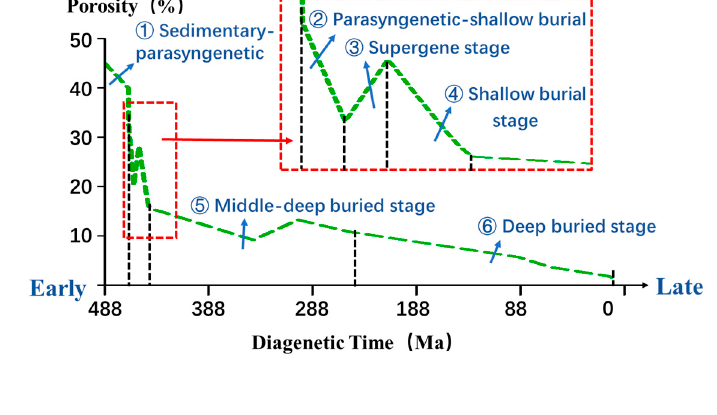
Figure 7. Calcite and dolomite content distribution after 0.01 My, 0.05 My and 0.2 My ( a – c, calcite with groundwater level of 100 m. d – f, Dolomite with groundwater level of 100 m. g – i, Calcite with groundwater level of 50 m).